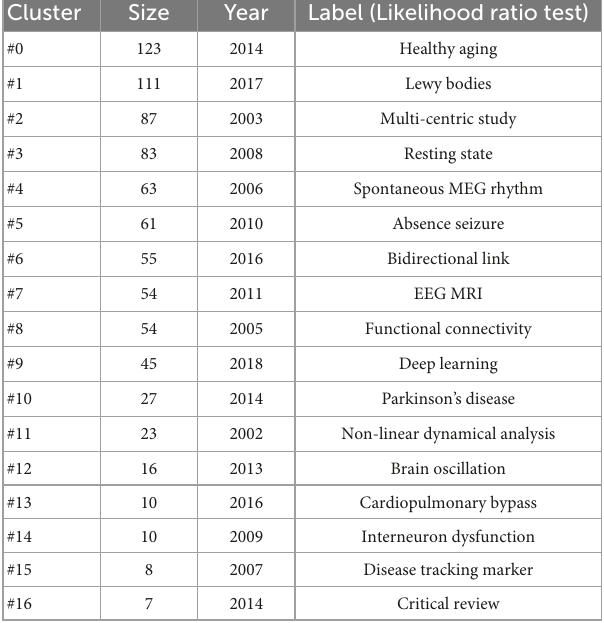
TABLE 7 Specific content of cluster